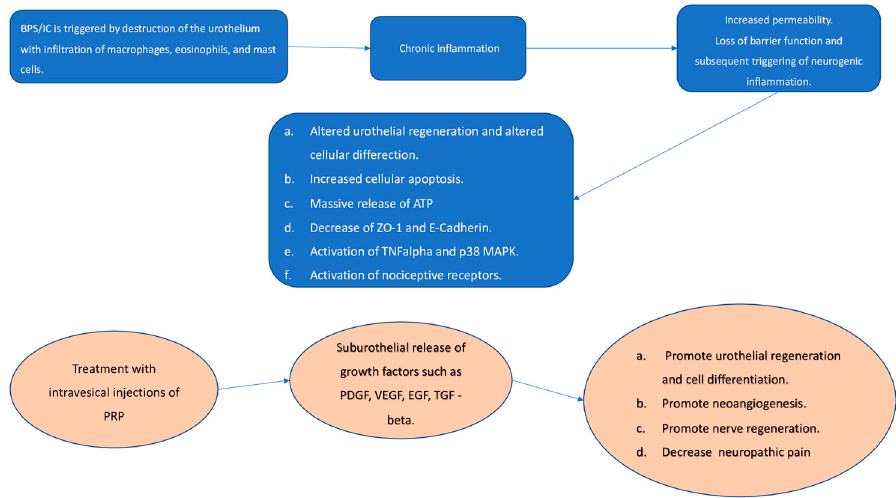
Figure 2. Possible therapeutic effects of intravesical injections of platelet-rich-plasma (PRP). ATP: Adenosine triphosphate; ZO-1: zonulae occludens-1; TNF alpha: tumor necrosis factor; MAPK: mitogen-activated protein kinase; PDGF: platelet-derived growth factor; VEGF: Vascular endothelial growth factor; EGF: Epidermal growth factor; TGF-beta: Transforming growth factor.